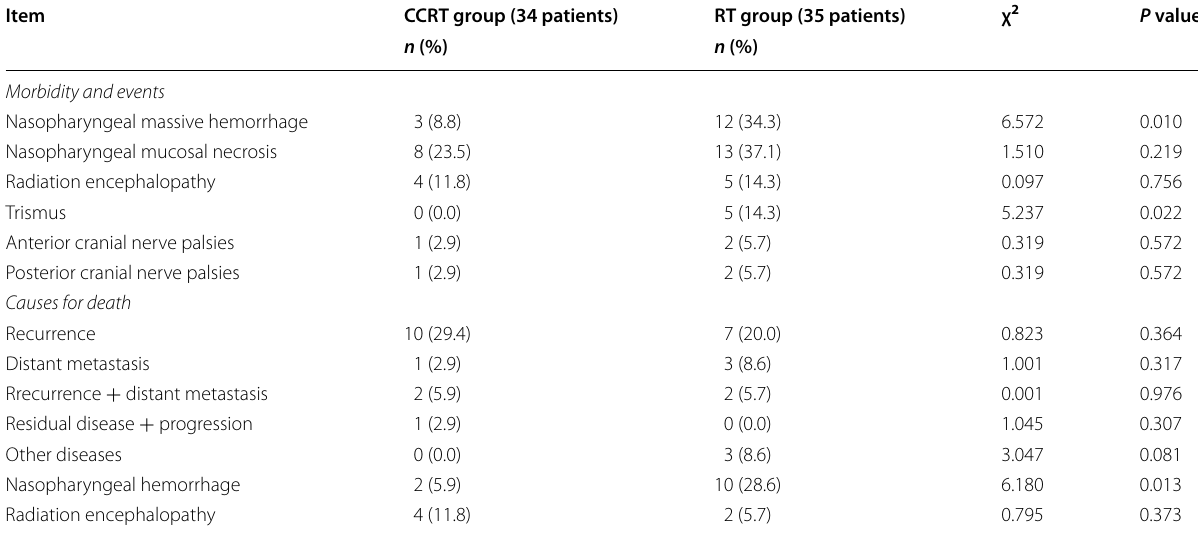
Table 4 Morbidity events and causes for